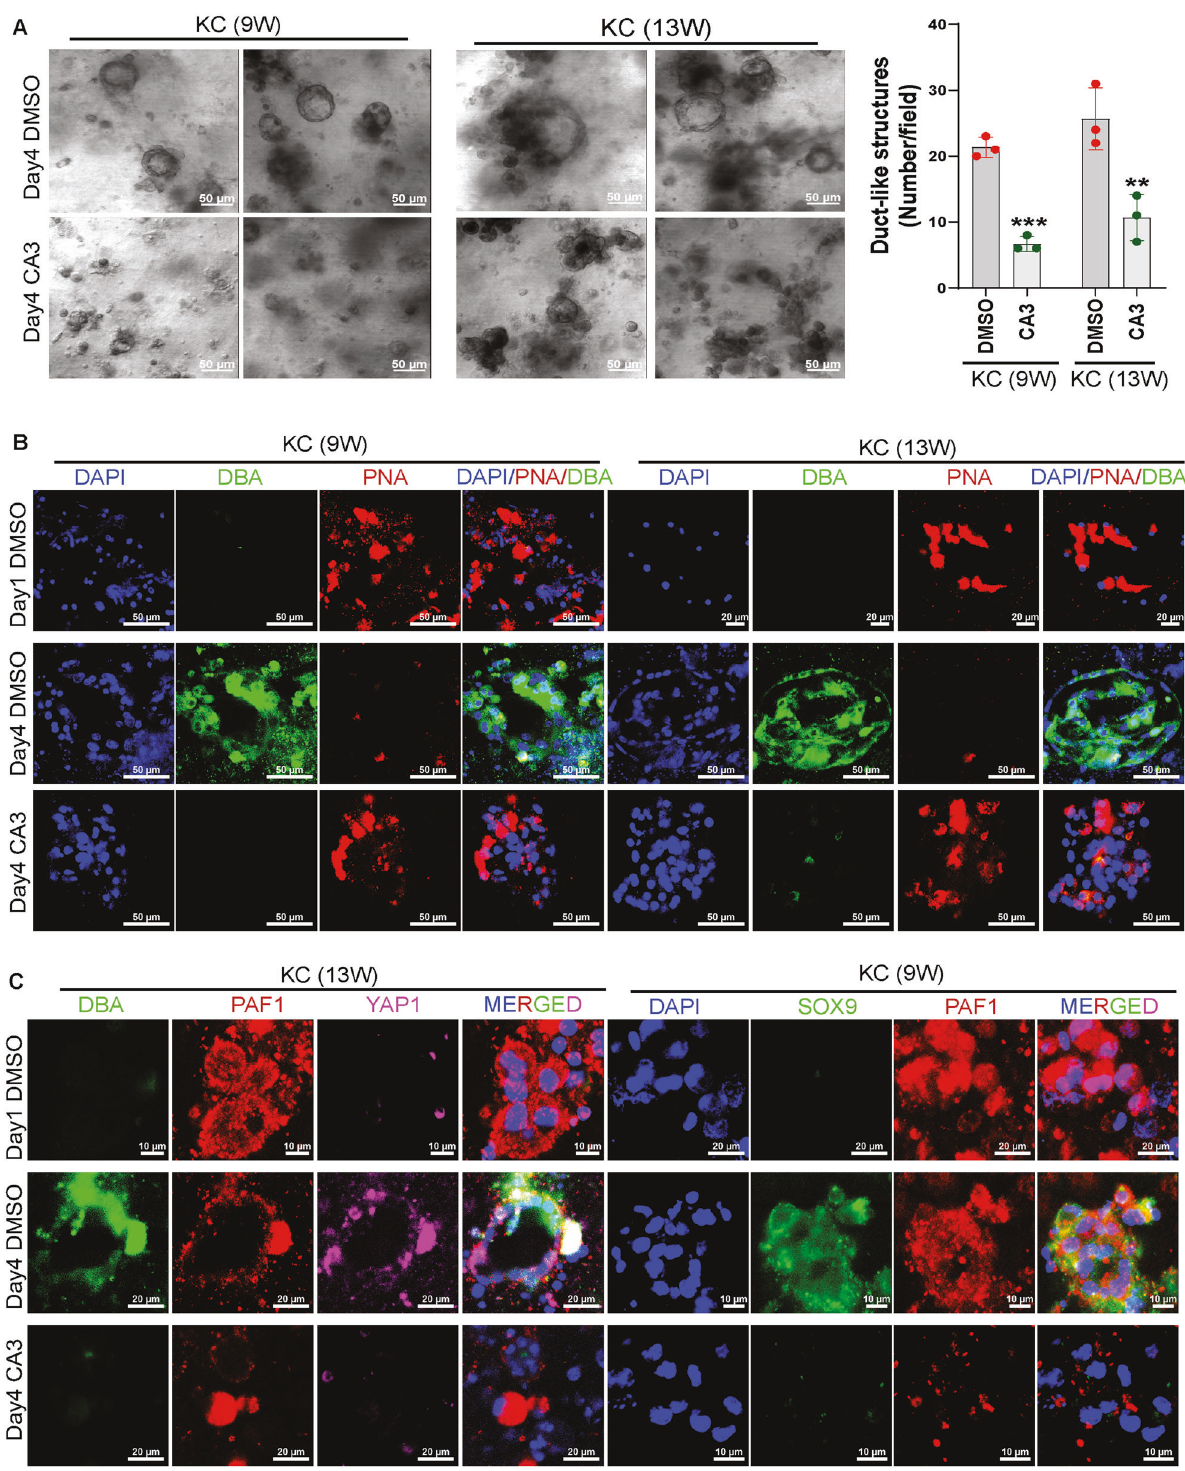
Fig. 6 CA3 inhibits ADM, SOX9 expression, and PAF1/YAP1 co-expression. A Light microscope images of pancreatic acinar cell explants from KC mice embedded in collagen treated with vehicle control or CA3 for 72 hr. The bar graph shows the number of duct-like structures per fi eld. Data are mean ± SD, n = 3. Signi fi cance was determined with a student ’ s t test. * p < 0.05, ** p < 0.01, *** p < 0.001, ns: non-signi fi cant, p > 0.05. B , C Confocal images of whole-mount immuno fl uorescence staining on the acinar explants embedded in collagen treated with vehicle control or CA3. Explants in collagen discs were stained with FITC-labeled Dolichos bi fl orus agglutinin (DBA), a duct-speci fi c lectin, and rhodamine-labeled Peanut agglutinin (PNA), an acinar-speci fi c lectin, and antibodies for PAF1, YAP1, and SOX9.